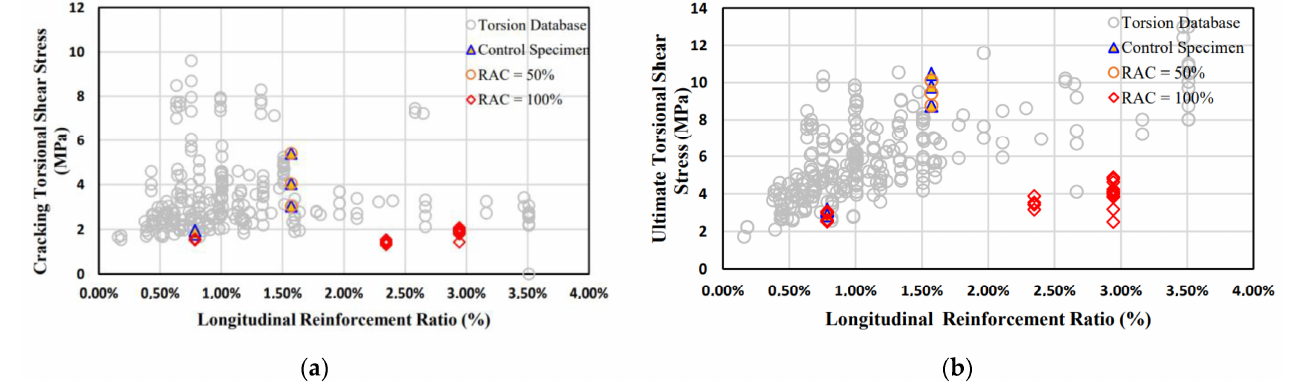
Figure 4. Effect of longitudinal reinforcement: ( a ) on cracking torsional shear stress; ( b ) on ultimate torsional shear stress.